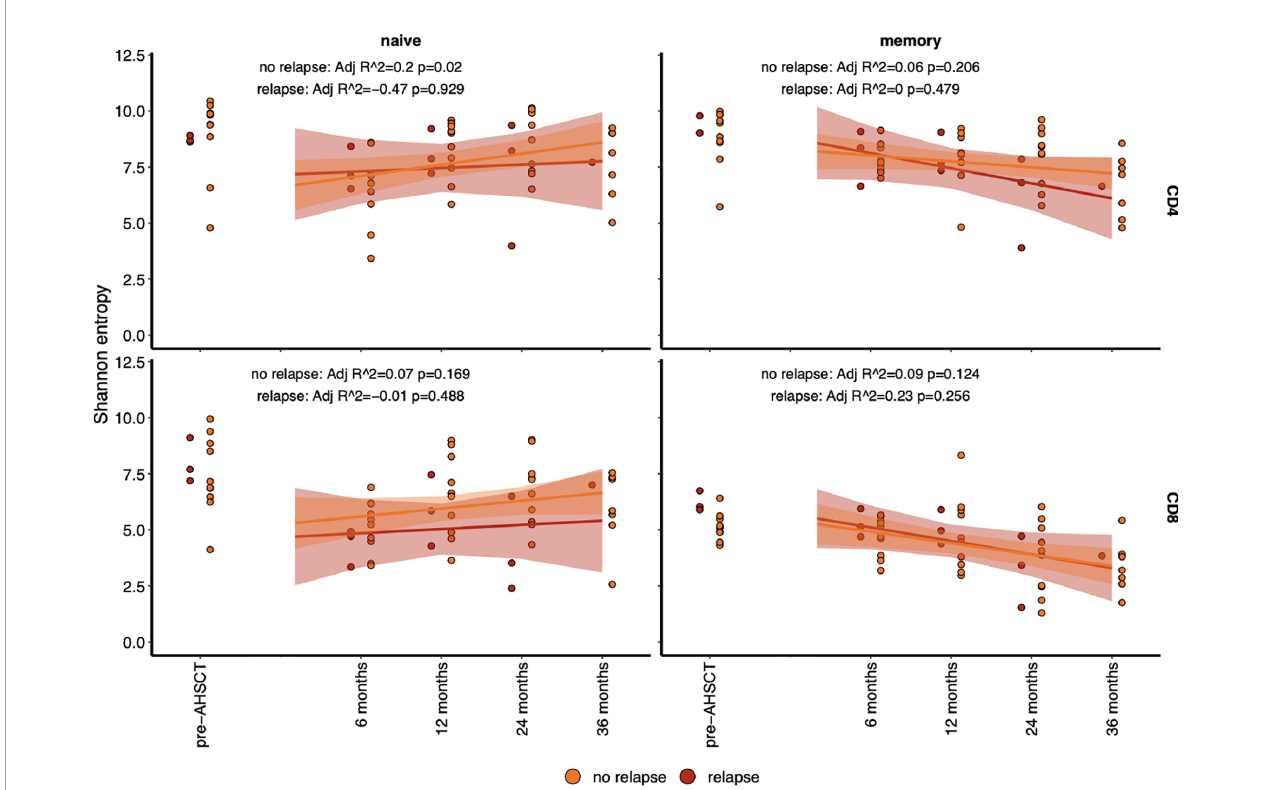
FIGURE 7 | Diversity (as determined by Shannon entropy) in lymphocyte subsets analysed by relapsed (red) patients and non-relapsed (orange) patients. The entropy of naïve (CD45RA+) population (left) and memory (CD45RO+) population (right), with CD4+ (top) and CD8+ (bottom) have been plotted before and after AHSCT. A line of fi t, and signi fi cant for each population is depicted per panel. The only signi fi cant line of fi t, with an increase in diversity is in the CD4+CD45RA+